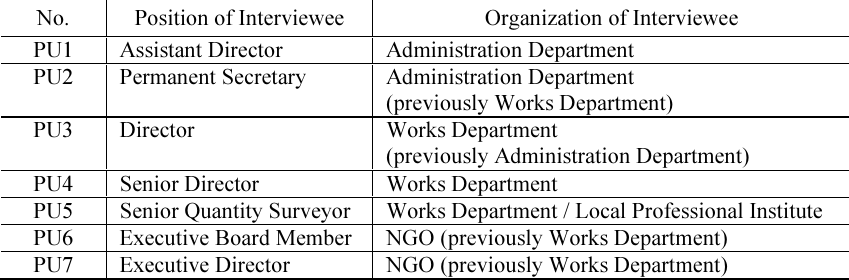
Table 4. List of Interviewees from the Public sector in Australia